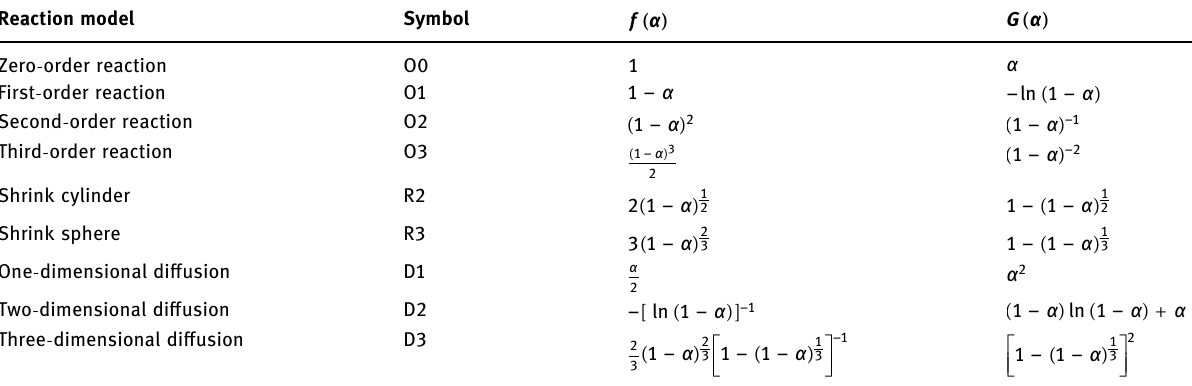
Table 3: Reaction model integral